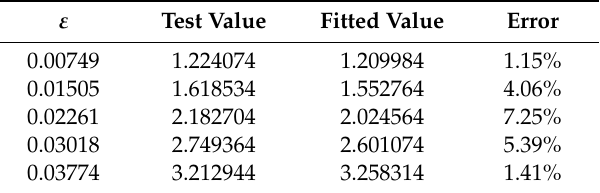
Table 19. The deviation between the test and calculated values for specimen 3 under 500 ◦ C